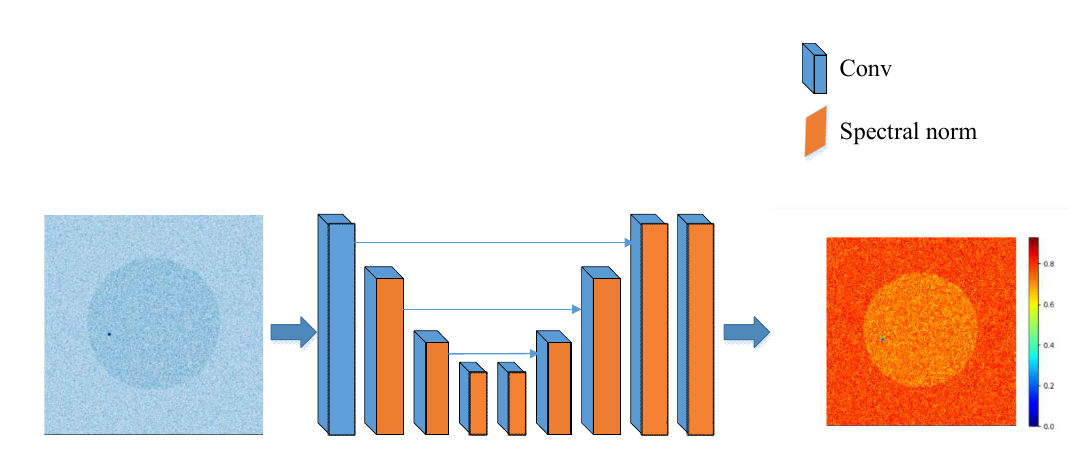
Figure 5. The architecture of the U-Net discriminator with spectral normalization.